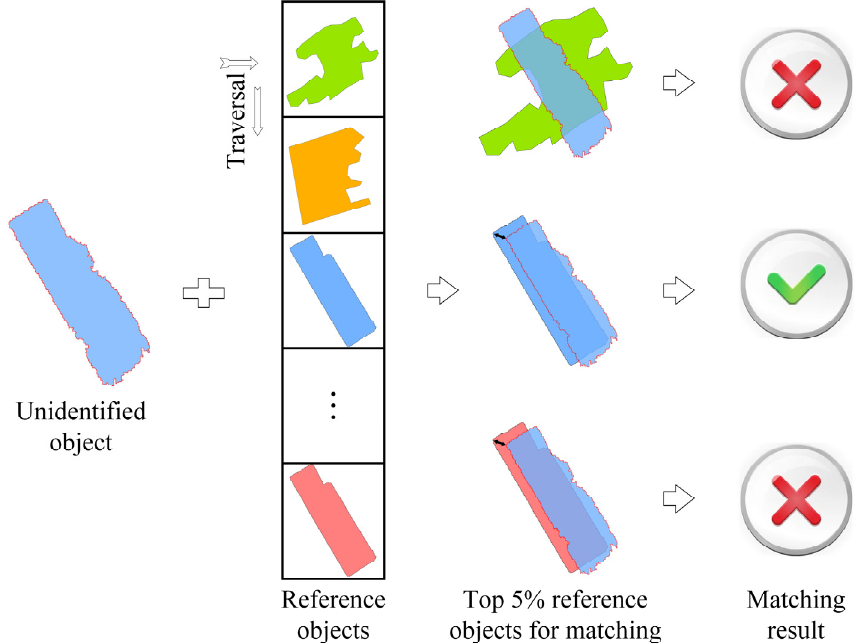
Figure 5. The matching process for significant objects. There are two forms: shape matching and spectral matching, which are represented by the shapes and colors of objects in the figure, respectively. √ indicates successful matching, while × indicates failed matching.